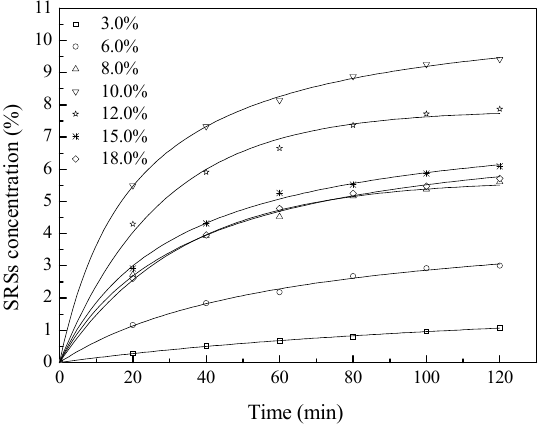
Figure 2. Enzymolysis of chitosan at different substrate concentrations.